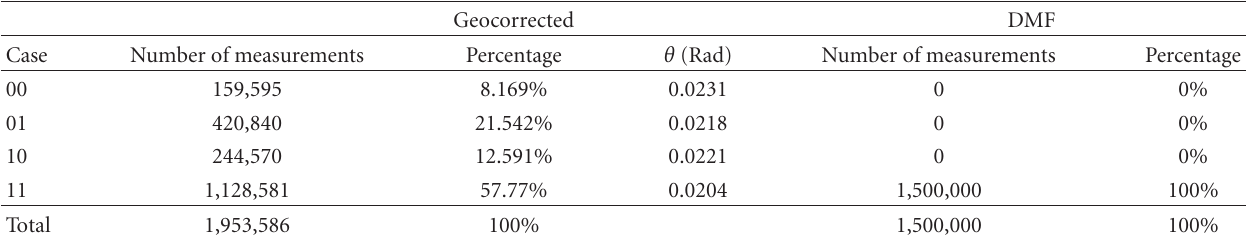
Table 1: Percentage of measurements and di ff erence accuracy of the geo-corrected and DMF versions of the dataset for the 00, 01, 10, and 11